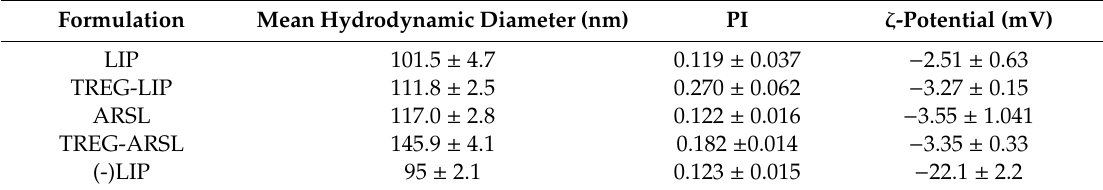
Table 2. Physicochemical properties of ARSL, TREG-ARSL and control liposomal formulations, formulated in PBS bu ff er (pH 7.40). (-)LIP are liposomes with lipid composition (PC / PG / Chol 8:2:5 mol /